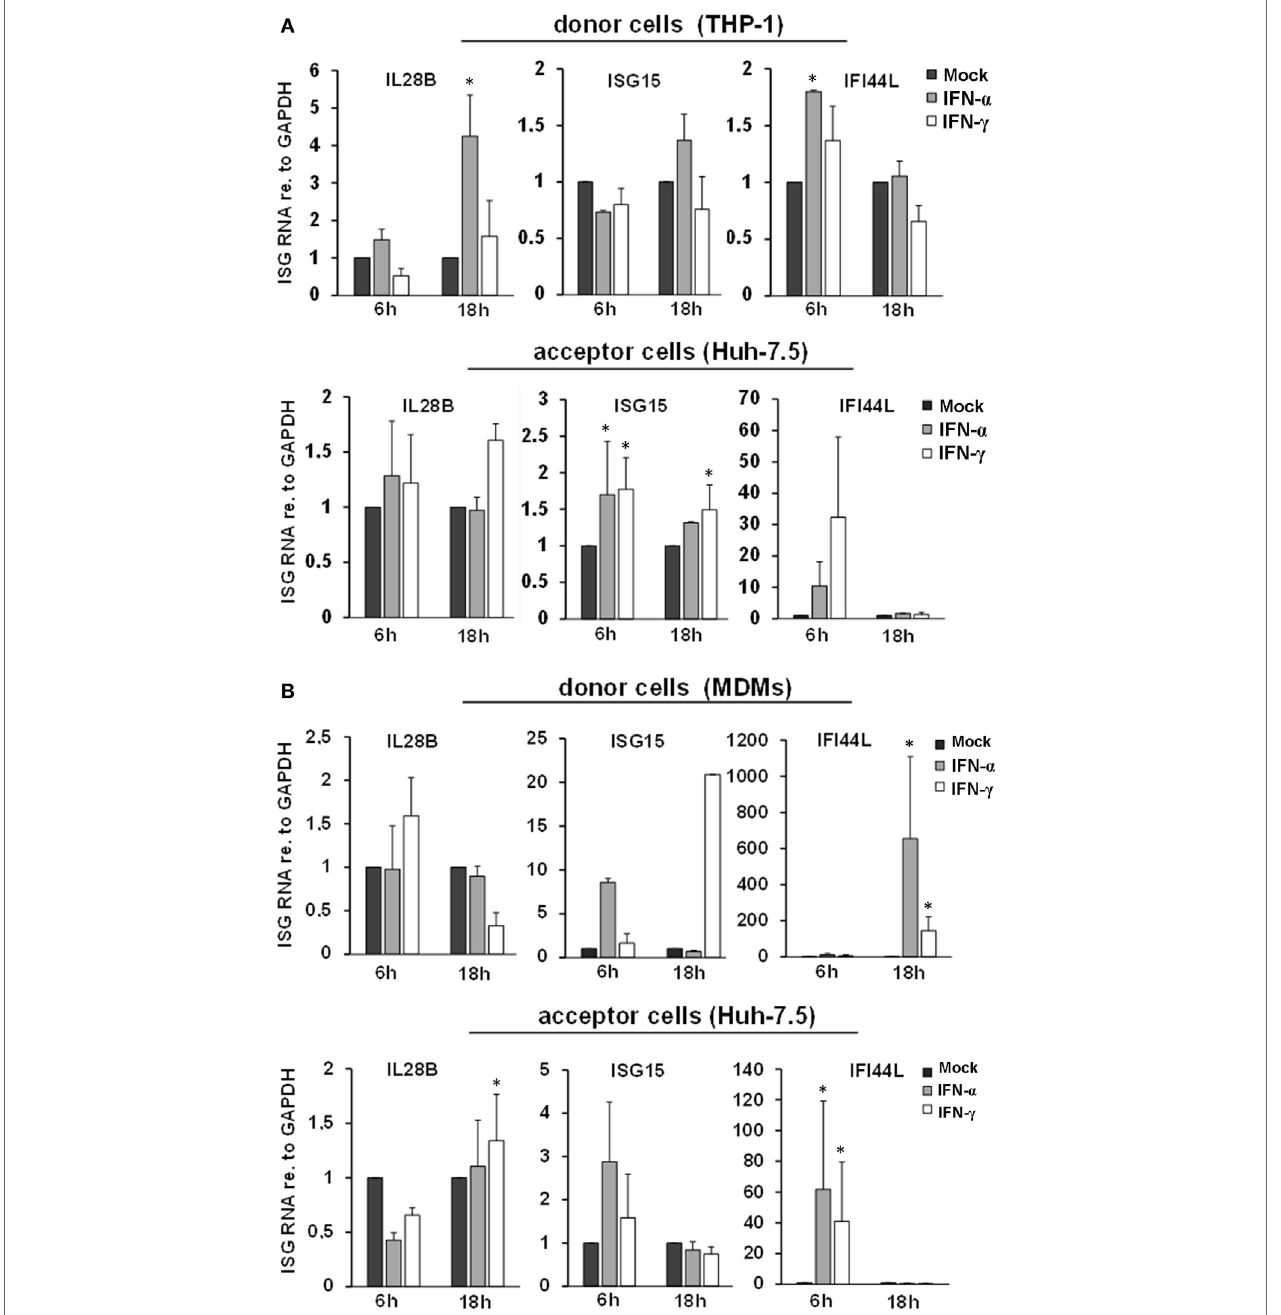
FigUre 2 | ISG induction and intercellular transfer from interferon-pulsed THP-1 cells (a) and MDMs (B) . Relative quantities of IL28B, ISG15, and IFI44L mRNAs were determined in THP-1 cells (a) and MDMs (B) (donor cells), as well as in hepatoma cells harboring subgenomic hepatitis C virus replicons (acceptor cells) by quantitative PCR. Donor cells were treated with mock, IFN- α (500 IU/ml), or IFN- γ (25 ng/ml) for 1 h and washed with PBS. After 6 and 18 h, the supernatant was transferred to acceptor cells, and mRNA was isolated from donor cells. 24 h after transfer, mRNA was isolated from acceptor cells. mRNA expression in mock- treated cells ( black bars ) was normalized to 1 and compared with IFN- α ( gray bars ) and IFN- γ ( white bars ) treated cells (* P <